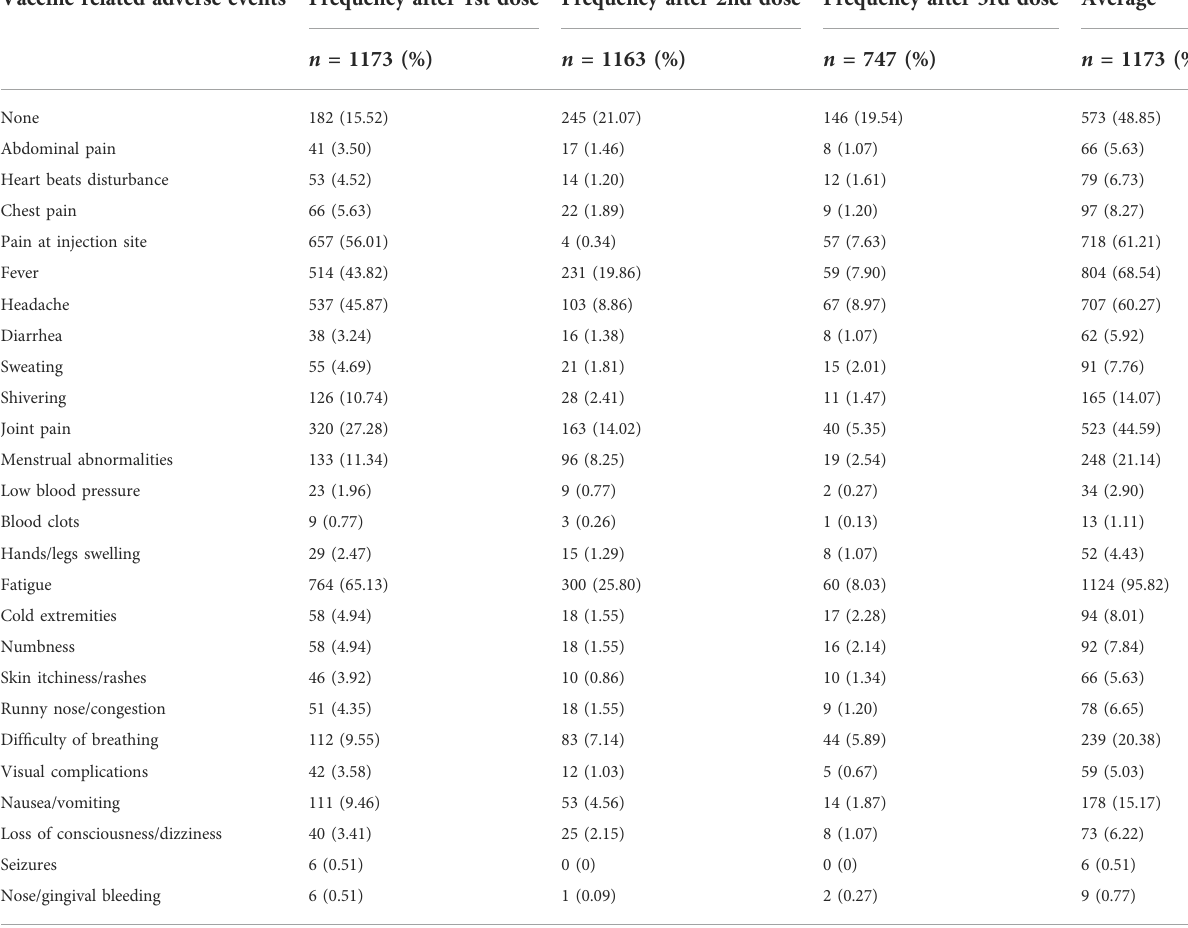
TABLE 4 Frequency of adverse events after administration of different vaccine